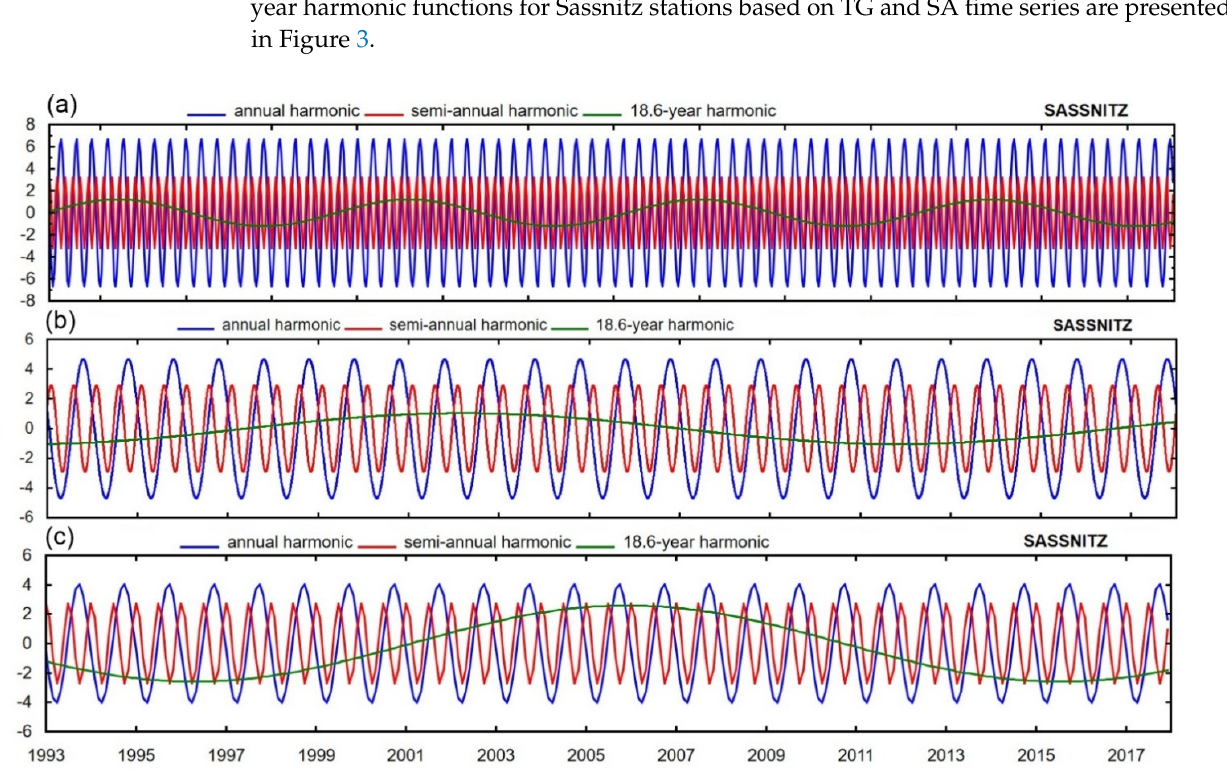
Figure 4. ( a ) Annual, ( b ) semiannual and ( c ) 18.61-year amplitudes of the seasonal cycle based on SA and TG time series. The correlation coefficients for amplitude were calculated based on SA and TG data (blue circles-dispersion plot; area marked by red dashed lines-95% confidence interval of the regression line). The amplitude units are centimetres. The correlation coefficient for annual variations from two independent observation techniques was determined at 0.92. The mean annual amplitude was ±5.59 cm with an estimation error of ±1.32 cm for TG data and ±6.17 cm for SA data with and estimation error of ±1.44 cm. The mean semiannual amplitude was ±2.57 cm with an estimation error of ±0.63 cm for TG data and ±1.79 cm for SA data with estimation error of ±0.42 cm. The correlation coefficient for semiannual variations was 0.72, which is a satisfactory result, but it was determined at only 0.34 for the 18.61-year cycle.